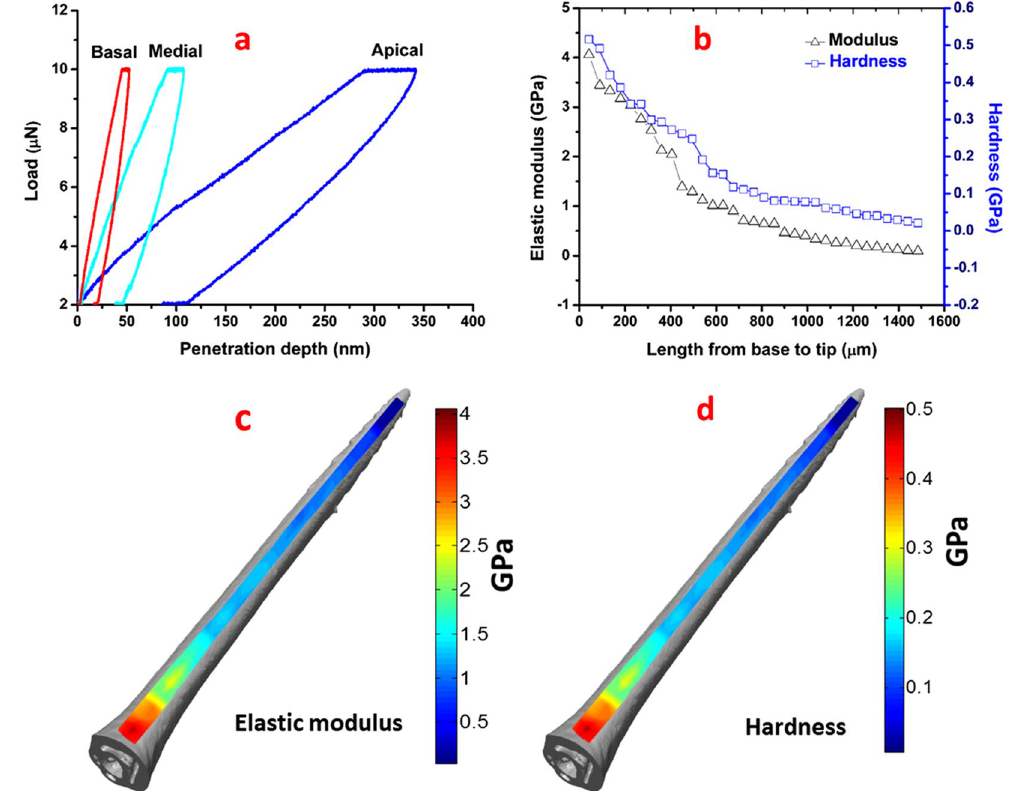
Figure 4. Quasi-static nanoindentation results of the honeybee stinger, ( a) Load versus penetration depth curve at different regions of the stinger, ( b ) Variation of the Modulus and Hardness along the length from base to tip of the stinger, ( c ) Modulus mapping along the length, and ( d ) Hardness mapping along the length. The honeybee stinger has the same trend of mechanical properties along the longitudinal direction from base to tip as in the case of wasp stinger.